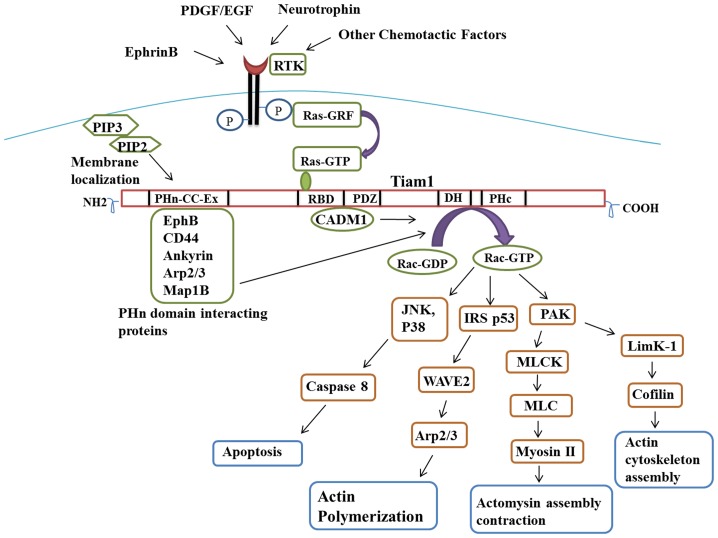
Tiam1 mediated signaling pathway.Schematic representation showing the upstream and downstream effects of Tiam1 in intracellular pathways. External stimulants phosphorylate the receptor tyrosine kinase which inturn activates Ras-GTP, binds to RBD domain of Tiam1. Interaction of EphB, CD44 and Ankyrin Proteins with PHn domain of Tiam1 and CADM1 with PDZ domain leads to the activation of Rac-GTP at DH domain of Tiam1. The activated Rac-GTP involves in various signaling pathways, mainly on actin cytoskeleton. The binding of PHn domain to phosphoinositide facilitates the membrane localization of Tiam1. PDGF: Platelet-derived growth factor; EGF: Epidermal growth factor; RTK: Receptor tyrosine kinase; PIP3: Phosphatidyl inositol triphosphate; PIP2: Phosphatidyl inositol diphosphate; PHn: N-terminal PH domain; RBD: Ras binding domain; PDZ: PSD-95/DglA/ZO-1 domain; DH: Dgl homology domain; PHc: C-terminal PH domain; JNK: Jun N-terminal kinase; PAK: p21-activated kinase.